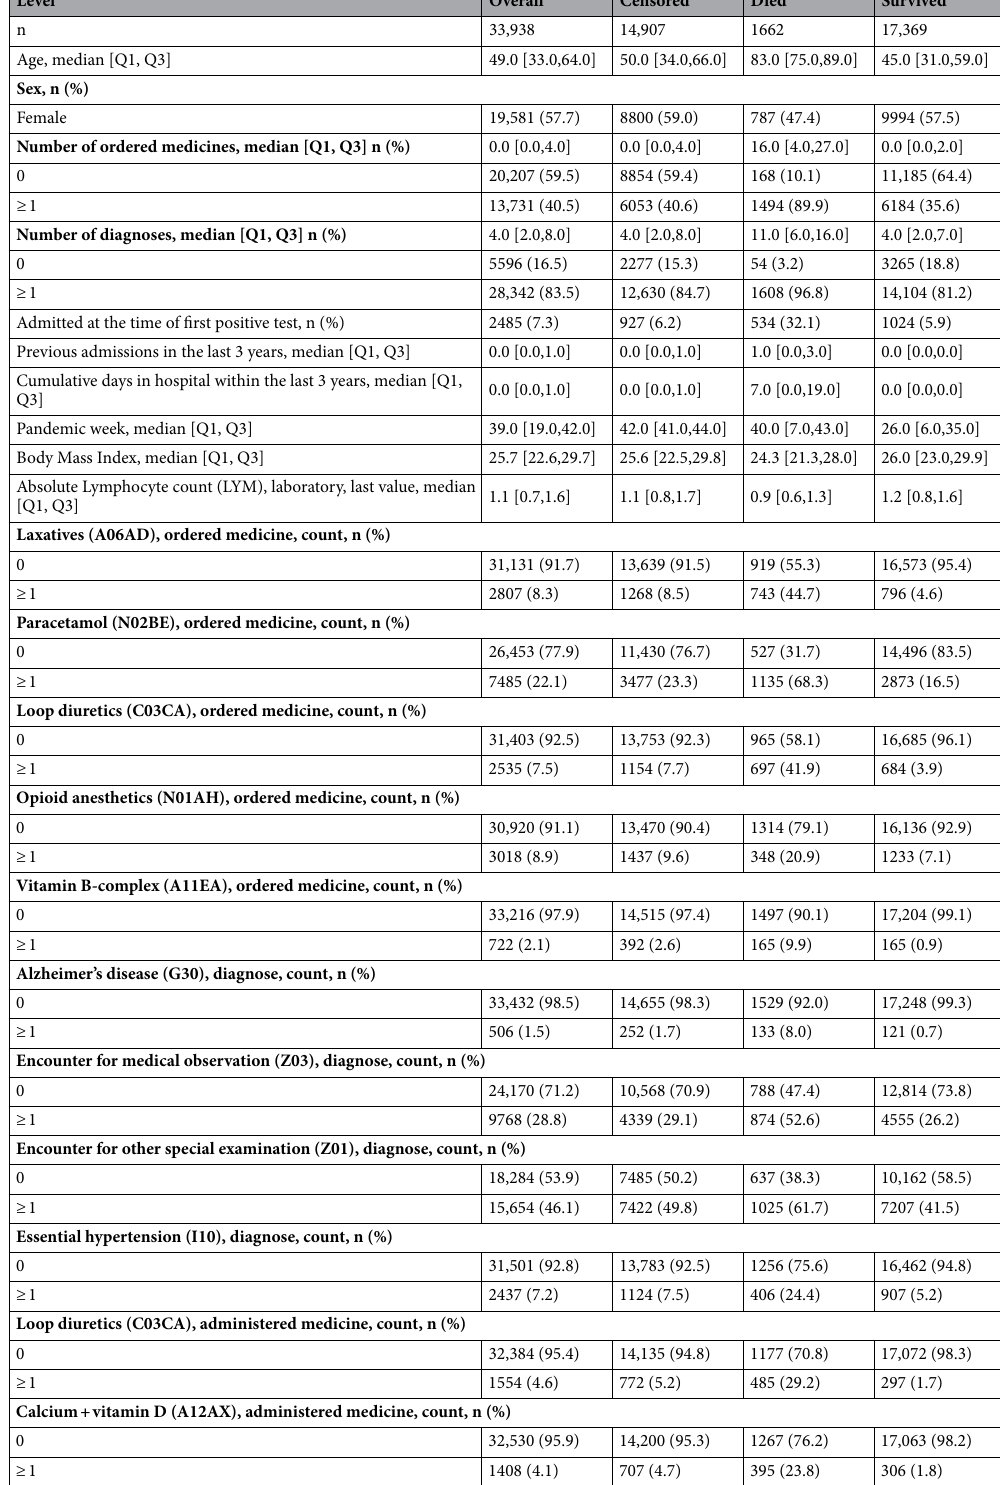
Table 1. Summary statistics of the cohort based on the final feature set. Values up to the day of the first positive SARS-CoV-2 test used for training and prediction were considered. Continuous variables were summarized by the median and interquartile ranges (Q1, Q3). Diagnoses and medicines with their ICD-10 and ATC codes in parentheses respectively were summarized as the number of patients with at least one code assigned. Only body mass index and absolute lymphocyte counts reported missing values for 17,823 and 32,803 patients respectively. Patients that had a positive test from the 8th of December 2020 (12-weeks before data generation) and did not die before the 2nd of March 2021 were